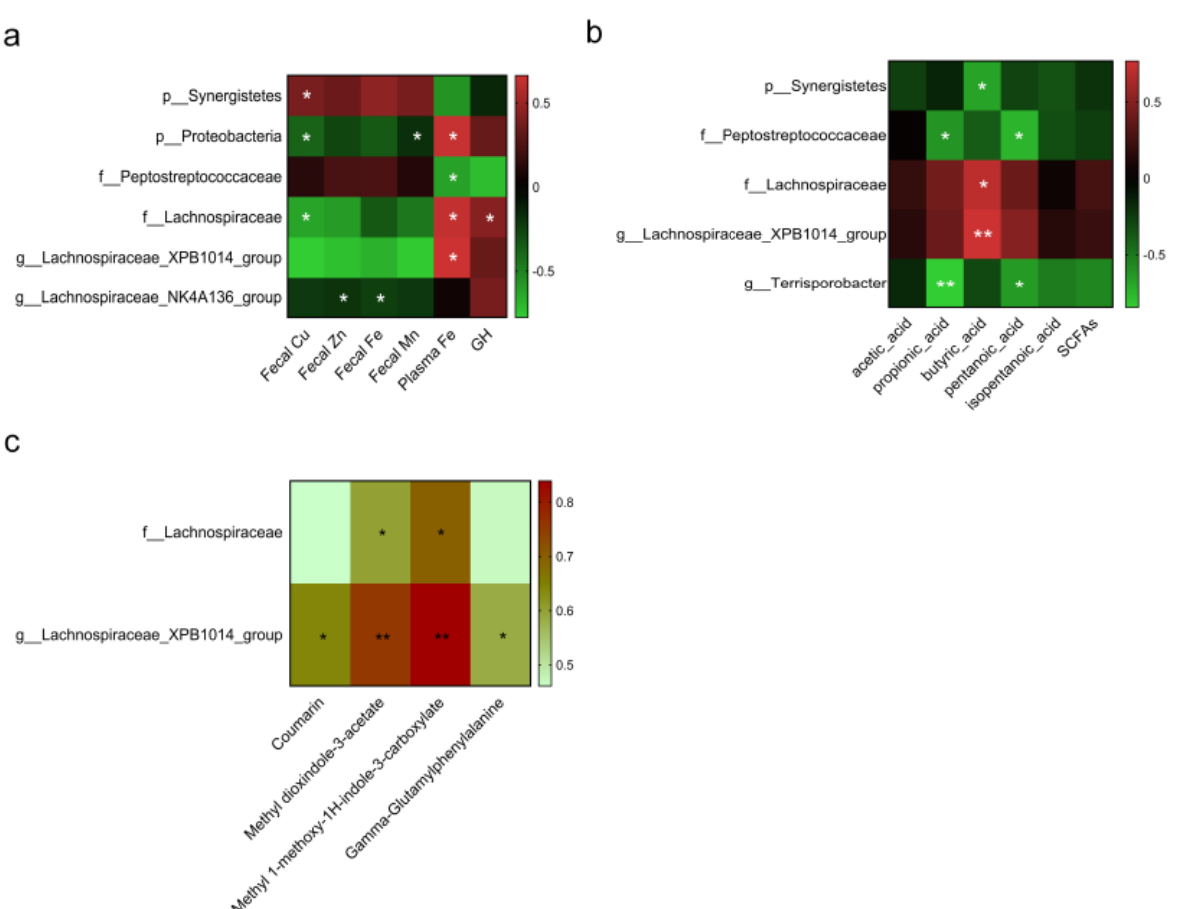
Figure 8. Correlation analysis between microbiota and metabolites, SCFAs, or fecal and plasma indicators. Spearman correlation analysis between differential microbiota and plasma indicators, fecal trace elements ( a ), SCFAs ( b ), and metabolites ( c ). Only significant correlations were presented. * represents a significant difference at p < 0.05, and ** represents a significant difference at p < 0.01. n = 6. GH, growth hormone; SCFAs, short-chain fatty acids.